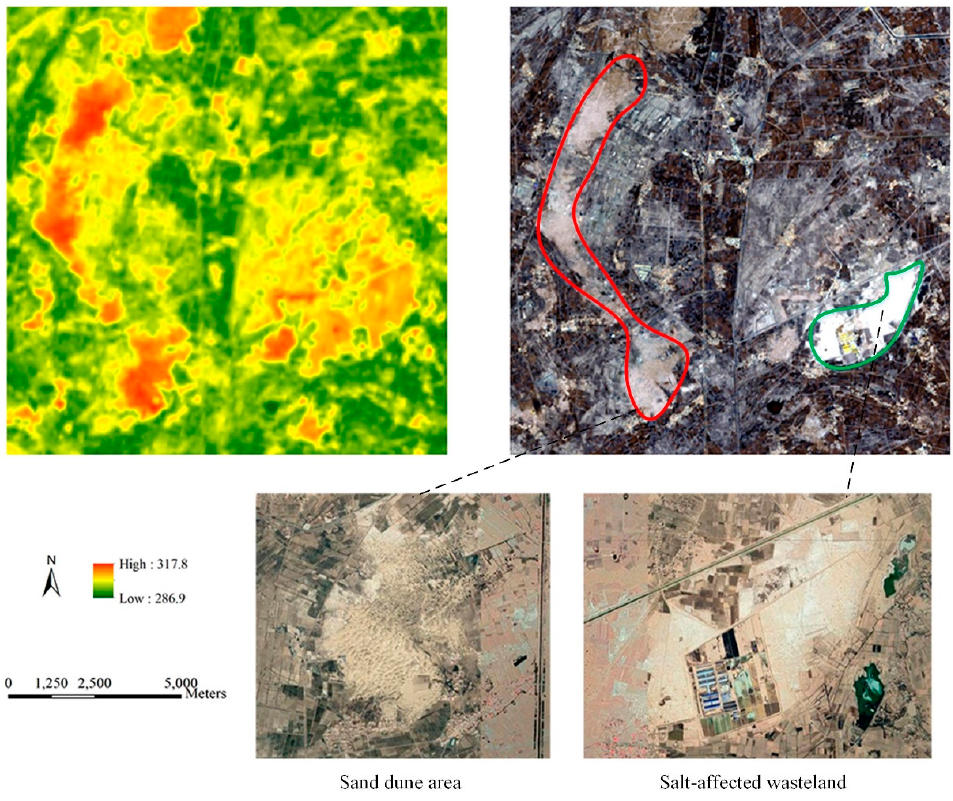
Figure 5. Example of the difference in brightness temperature between sand dune areas and abandoned salinized farmland. The top left subplot is the brightness temperature data (K) calculated from Landsat 8 OLI imagery (acquired on 10 July 2019). The top right is the corresponding composed RGB imagery. The red area of interest (AOI) denotes the sand dune area, and the green area is the abandoned salinized farmland. The lower subplot is the corresponding Google Earth map that shows the details of AOIs.